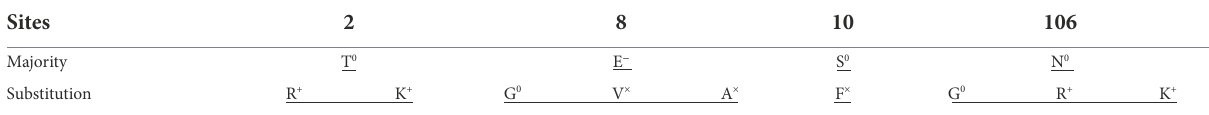
TABLE 3 Positions and polarities of the positively selected amino